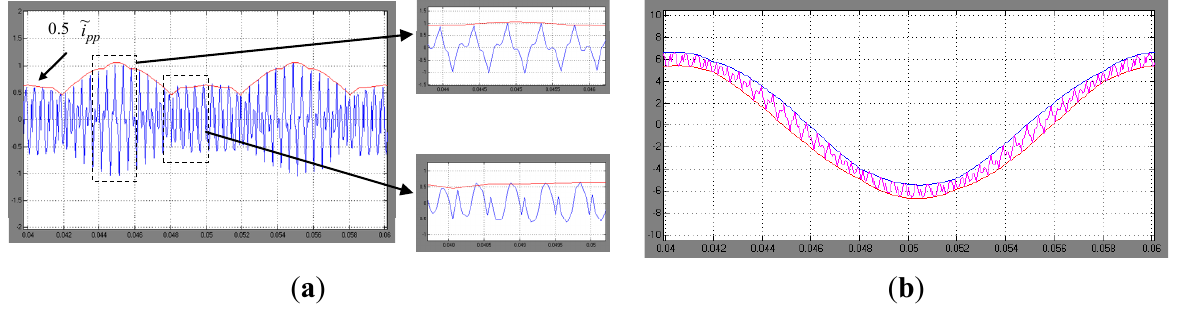
). ( a ) Simulation results (blue) and evaluated max